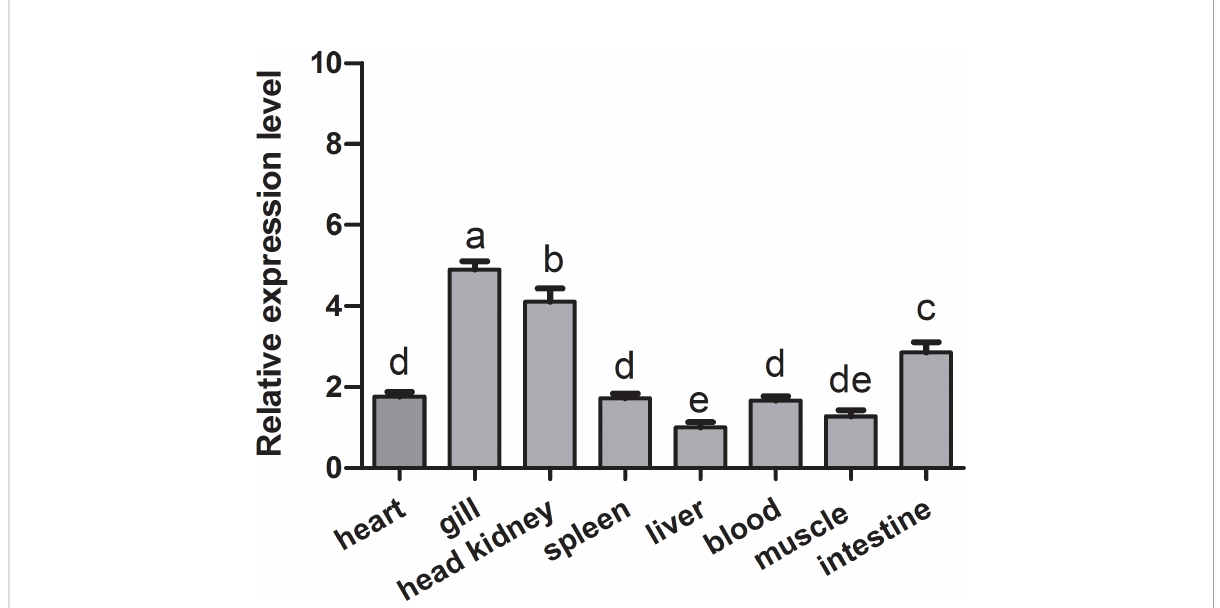
FIGURE 5 Relative expression levels of Ci MEKK3 in various tissues of healthy grass carp. Each bar represents the mean of the normalized expression levels of the replicates ( N = 3). Bars marked with different letters indicate signi fi cant differences among different tissues ( P <